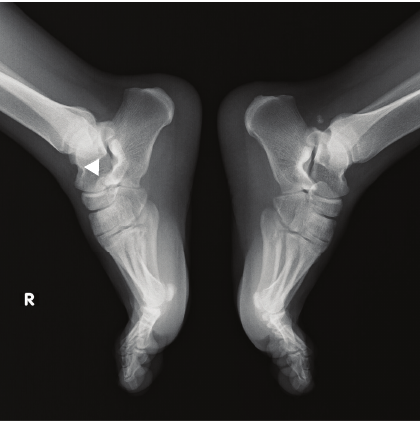
Figure 1: Lateral plain radiograph shows a suspicious fracture line of anterosuperior calcaneal process (white arrowhead).